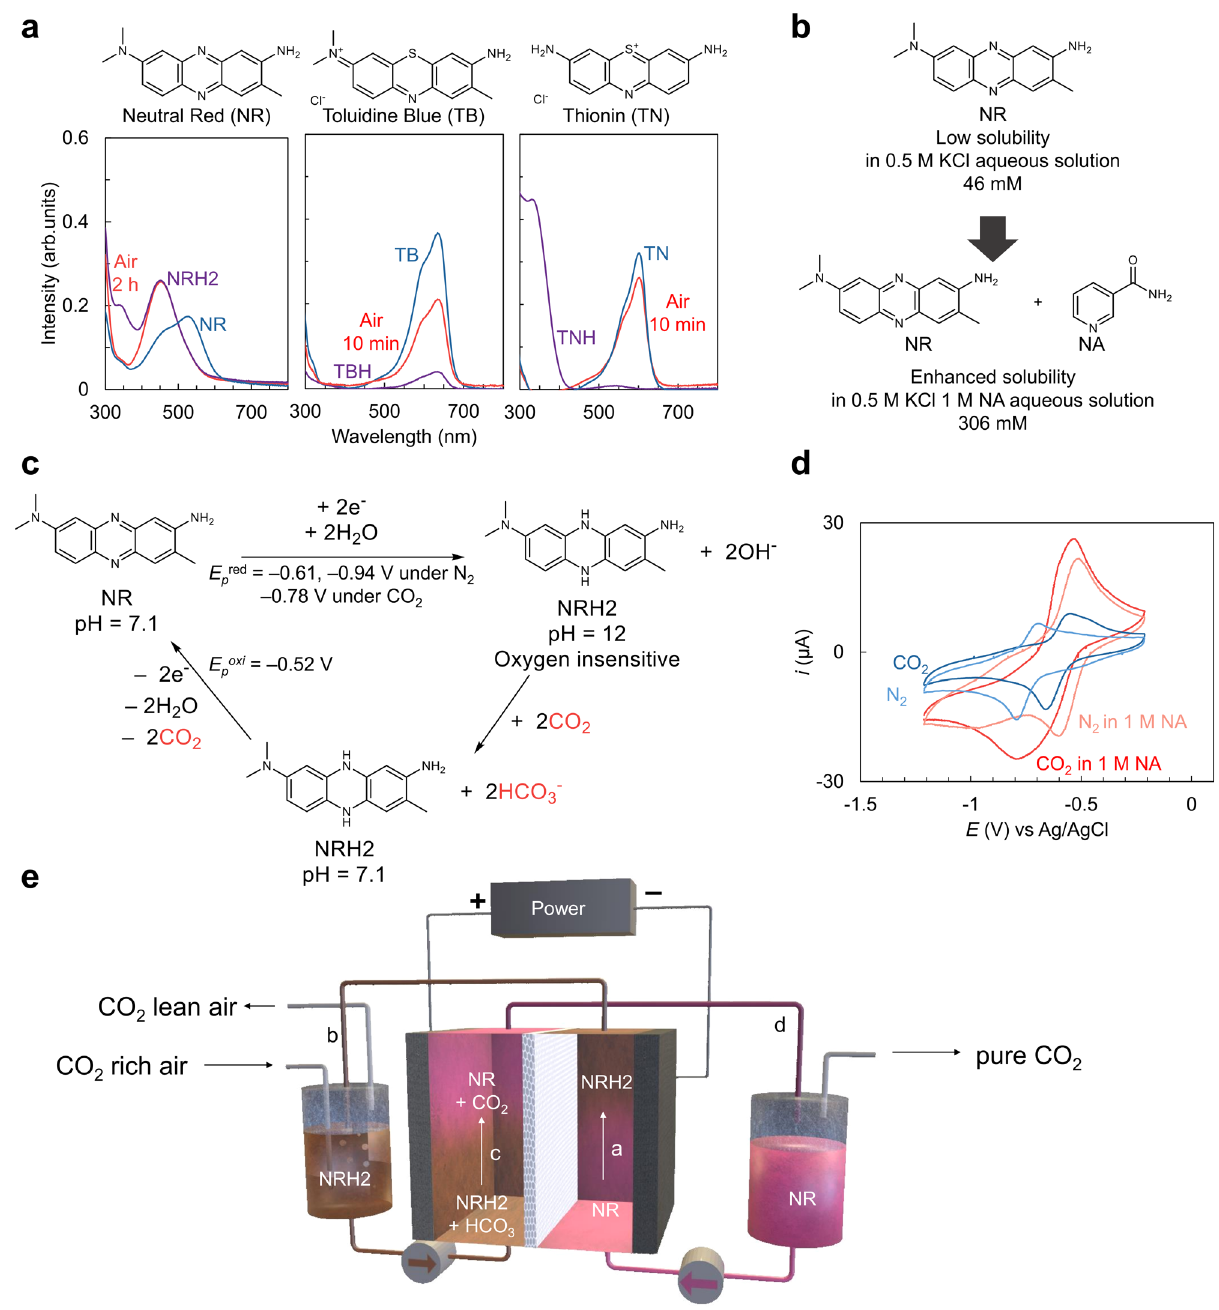
d The cyclic voltammograms of 5mM NR under nitrogen (pastel blue curve, pH 6) and CO 2 (blue curve, pH 7) in water with 0.1M lithium perchlorate (LiClO 4 ) as a supporting electrolyte, and those of 10mM NR under nitrogen (pastel red curve, pH 6) and CO 2 (red curve, pH 7) in water with 1M NA as a hydrotropic agent and 0.1M LiClO 4 as a supporting electrolyte. All CV curves were recorded at room temperature at a scan rate of 50mV/s with a glassy carbon working electrode. PotentialswererecordedversusAg/AgClasareferenceelectrode. e Overviewofthe continuous fl ow electrochemical cell with the NR/NRH2 redox cycle for CO 2 cap- ture and release